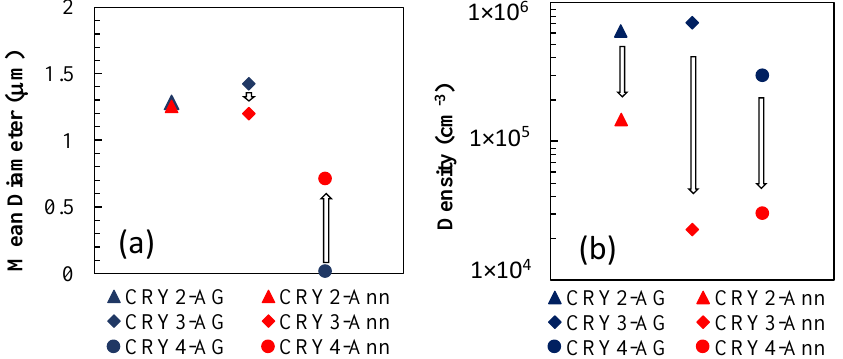
Figure 9. A comparison of Te inclusions; ( a ) size, and ( b ) density, for CdTe:Cl as-grown (AG) and after annealing at 750 °C for 12 h (Ann).